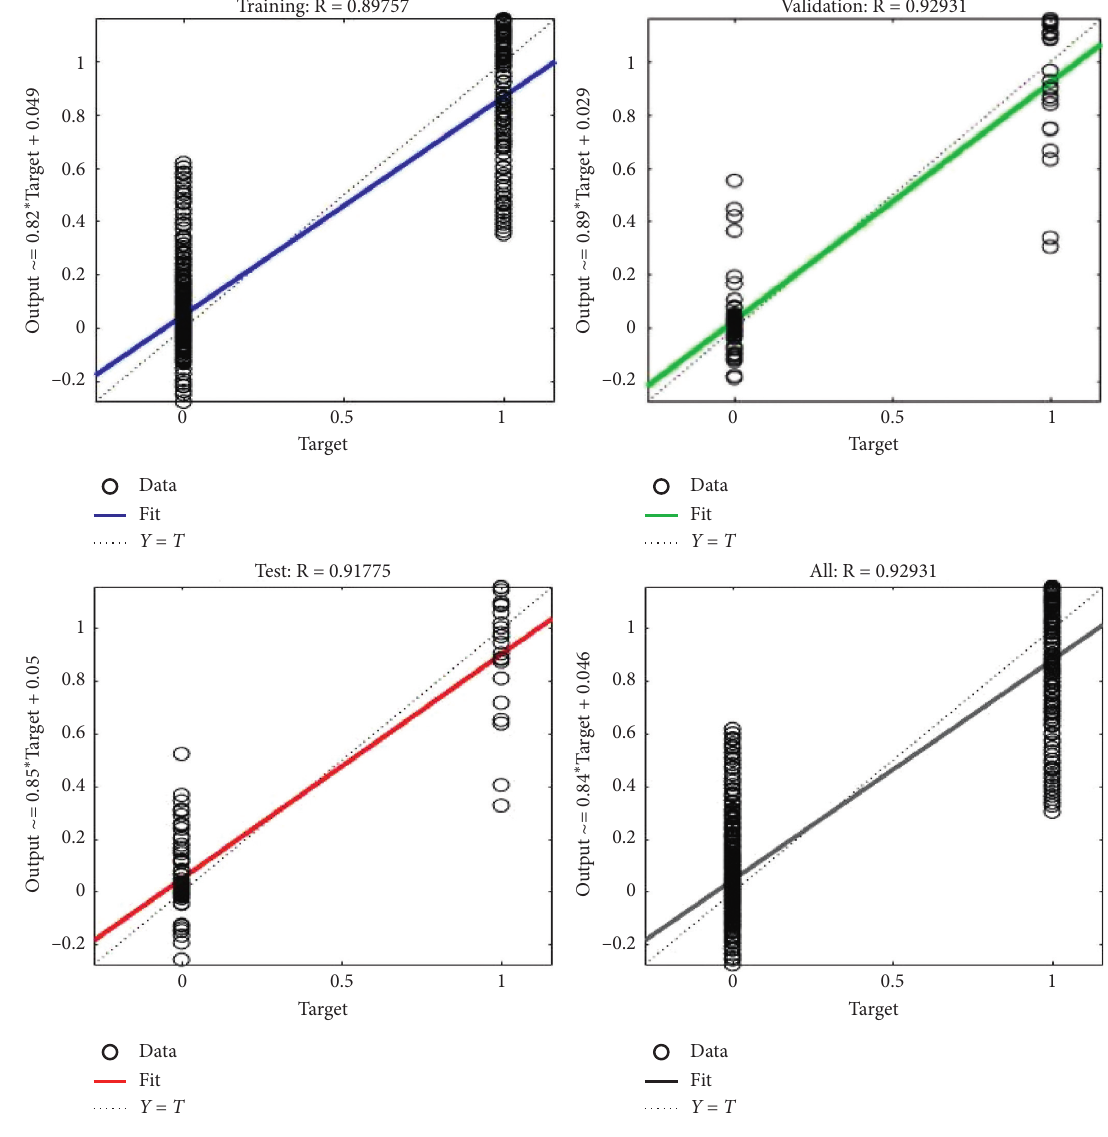
Figure 6: Regression analysis chart of sample data.